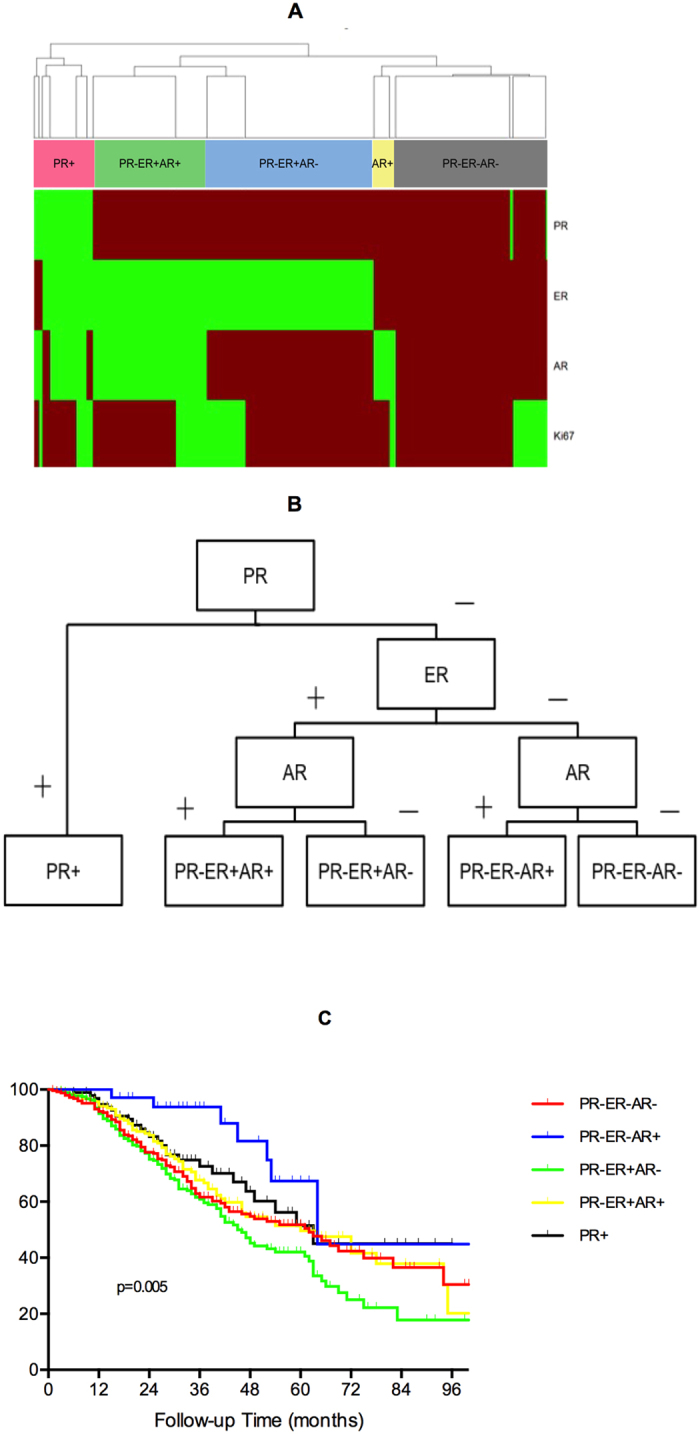
Molecular classification of patients based on clustering analysis of ER, PR, AR and Ki67 expression.(A) Clustering analysis divided the patients into five subgroups. Horizontally, the expression for the different receptors is depicted, with green indicating positive expression and red indicating negative expression. (B) Algorithm for the classification of the five subgroups. (C) Kaplan-Meier curve of OS stratified by the five subgroups.